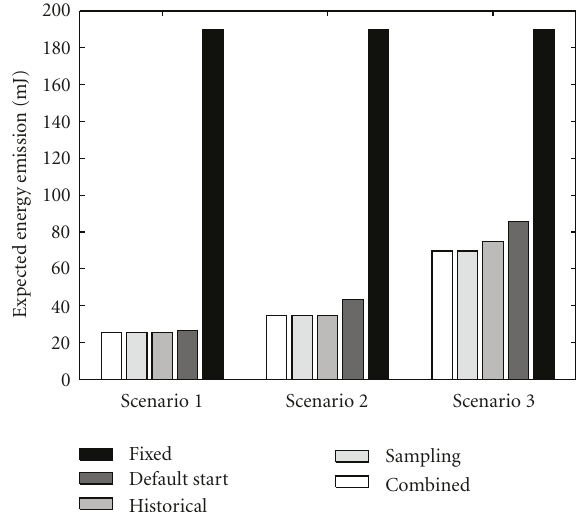
Figure 5: The initialization phase performance comparison (IEEE